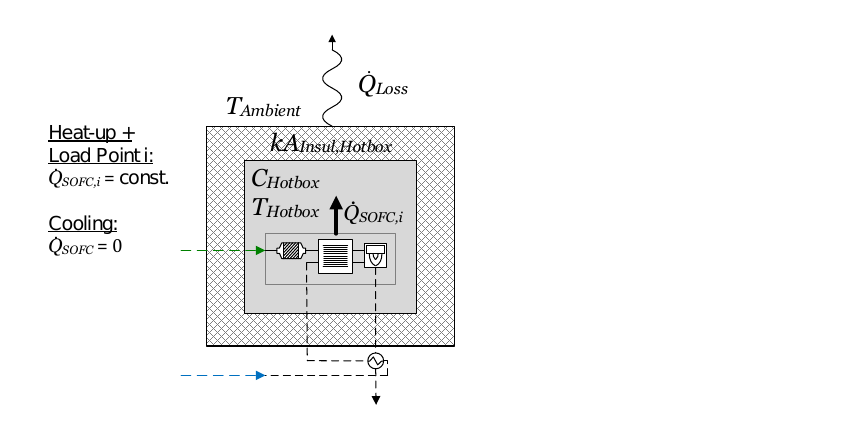
Figure 11. Reduced model of the SOFC system with visualization of the main characteristics.